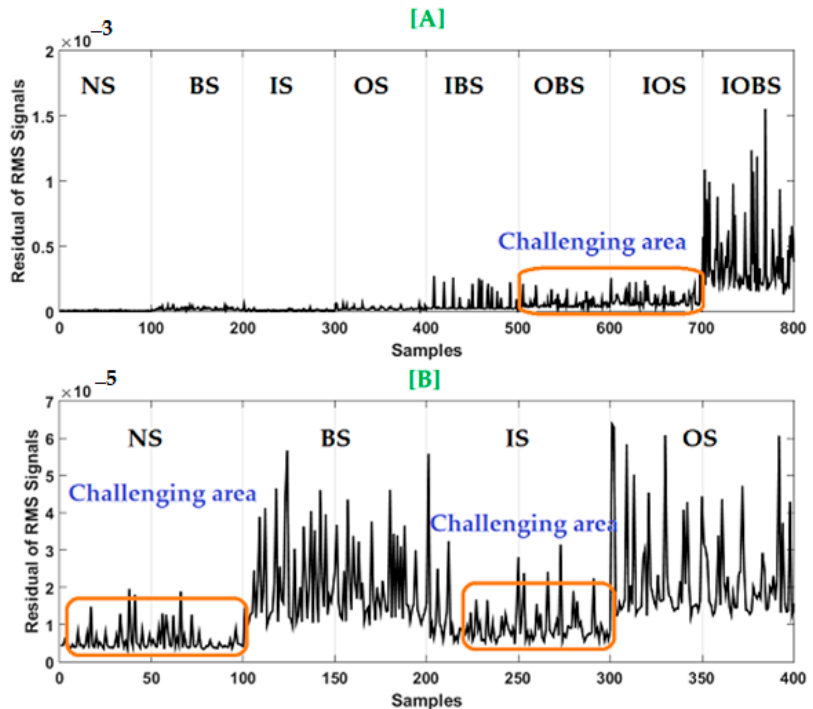
Figure 10. Residual RMS signal using high-order sliding digital twin. ( A ) all conditions, ( B ) zoom view for four conditions.